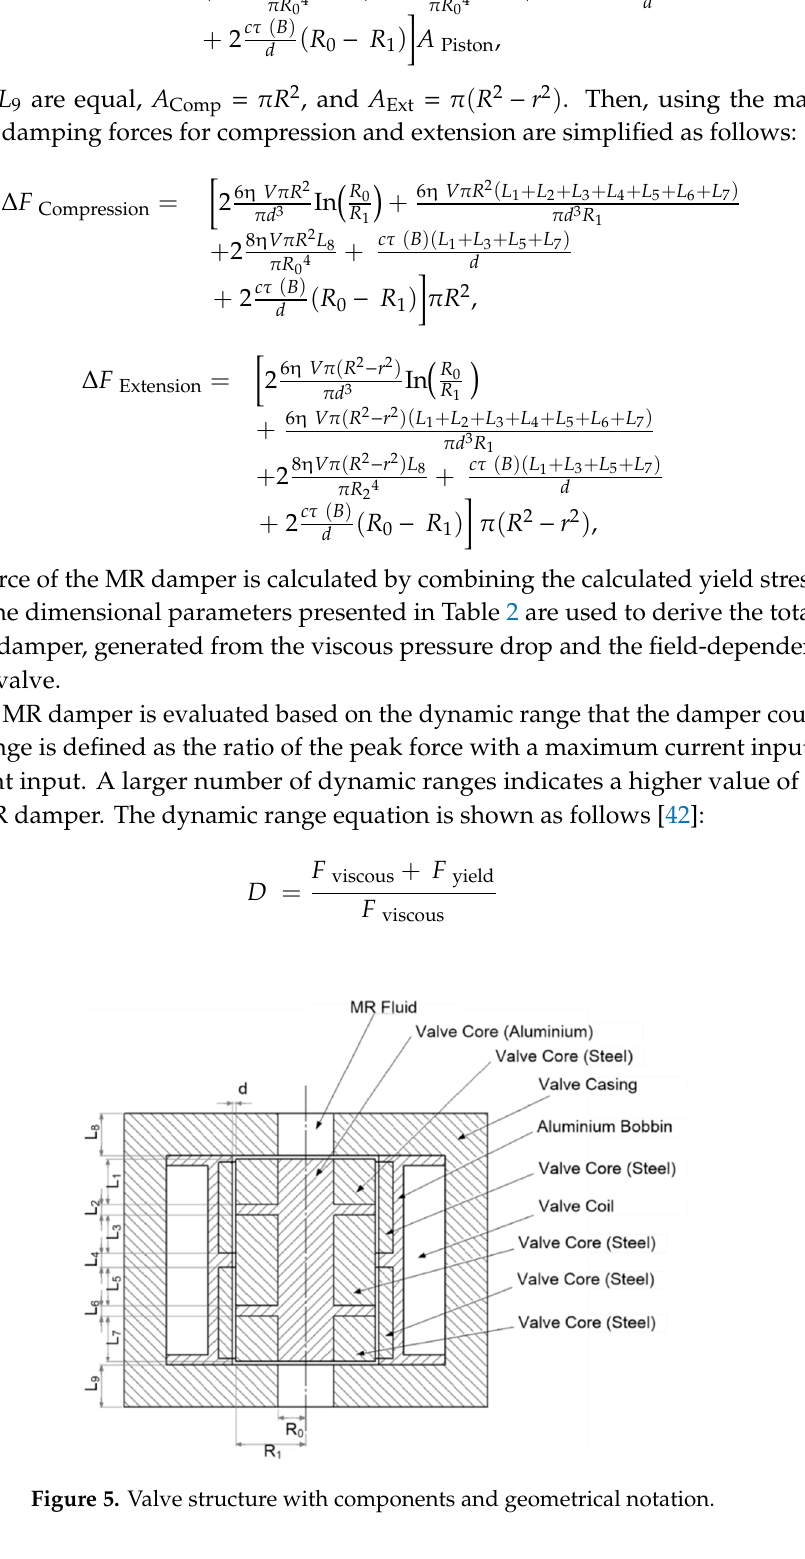
Table 2. List of parameters used for valve design. Parameter